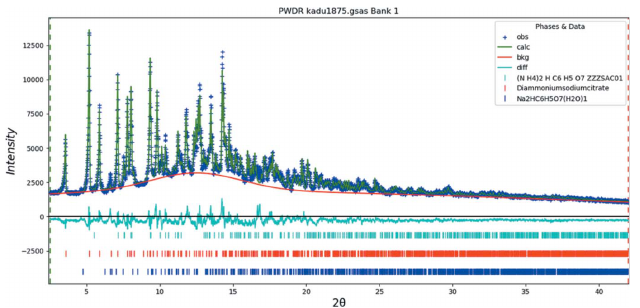
Figure 13 Rietveld plot for (II). The blue crosses represent the observed data points, and the green line is the calculated pattern. The cyan curve is the normalized error plot. The row of blue tick marks indicates the calculated reflection positions. The red and cyan tick marks indicate the reflection positions for the diammonium sodium citrate and diammonium hydrogen citrate impurities. The red line is the background curve.